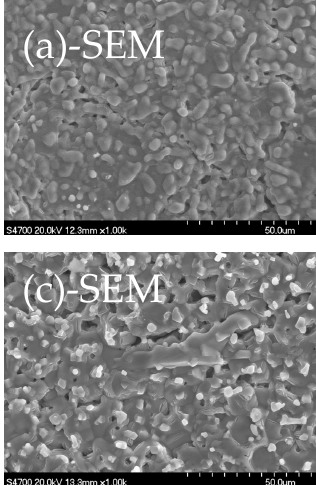
Figure 1. XRD analysis: ( a ) CaO and pure-C (1500 °C); ( b ) CaO+pure-C (1500 °C); ( c ) CaO+pure-C (1700 °C).